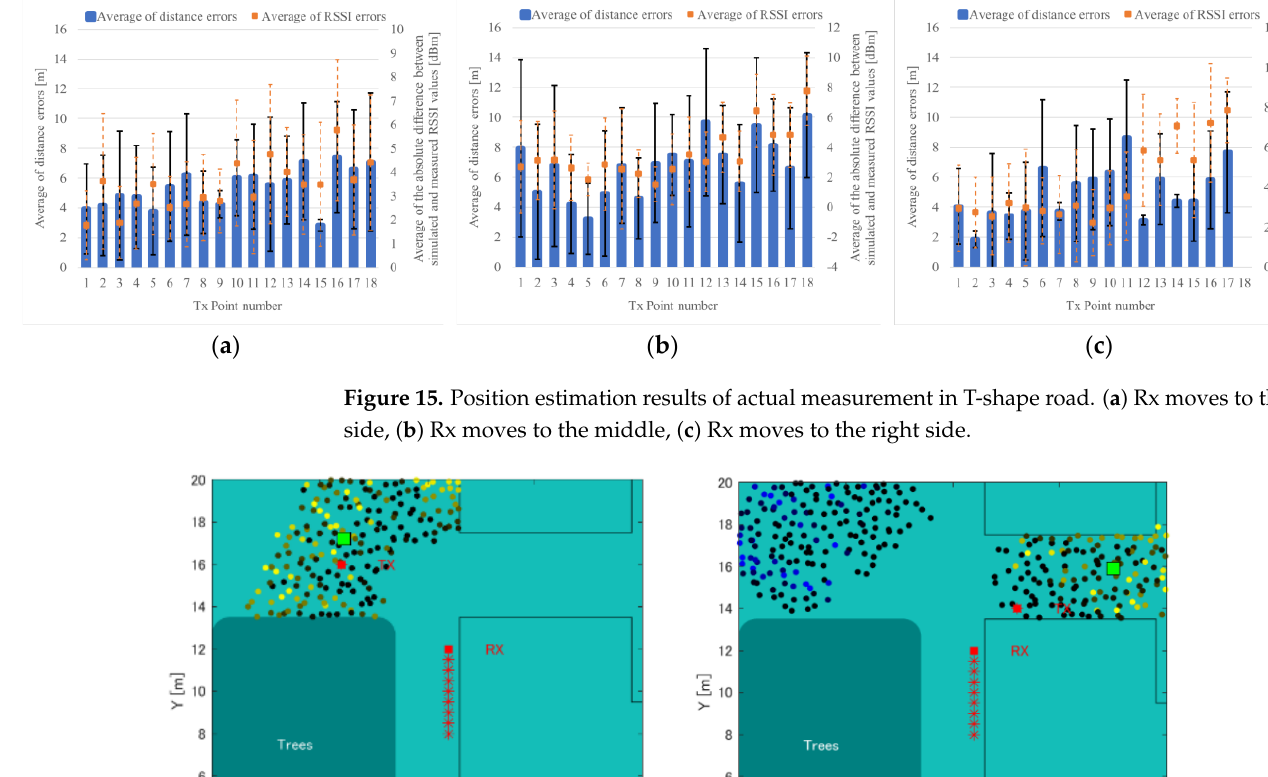
( c ) Figure 14. Position estimation results of measurement simulation in the T-shape road. (a) Rx moves to the left side of the road, (b) Rx moves to the middle of the road, (c) Rx moves to the right side of the road by the wall. 5. Experiment in an Outdoor Environment 5.1. Actual Measurement Experiment with Tx Stationary State Similar to the simulation experiment conducted in Section 4.2, the position estimation experiment is performed using the actually measured RSSI. As for the RSSI measurement method, a transmitter and a receiver are installed, as in the offset adjustment in the previ- ous section, and the measurement is performed 10 times for 10 s at each point. Addition- ally, the position estimation of each Rx movement for each Tx point in nine steps was repeated three times, and the evaluation was performed using the value obtained by av- eraging the errors. Herein, the BLE radio waves observed in the measurement environ- ment were all − 90 dBm or less, except for that of Pixel 4a, with minimum radio wave in- terference. The experiment was conducted on a day when the weather was fine and the wind speed was less than 5 m. Figure 15 shows the results of position estimation using the measured RSSI values, indicating the error of the distance between the estimated point and the actual point of Tx, and the difference between the RSSI value measured at that time and simulation. How- ever, considering TX may not be able to receive depending on the number of steps of each TX and RX, it was further evaluated. Figures 15a,b show the average error of the distance when Rx moves on the left side of the road, which is 5.3 m, and when Rx moves in the center of the road, which is 6.8 m. As shown in Figure 15c, the error average when Rx is moved on the right side of the road is 5.0 m, and 5.7 m as a whole. Table 1 shows the error